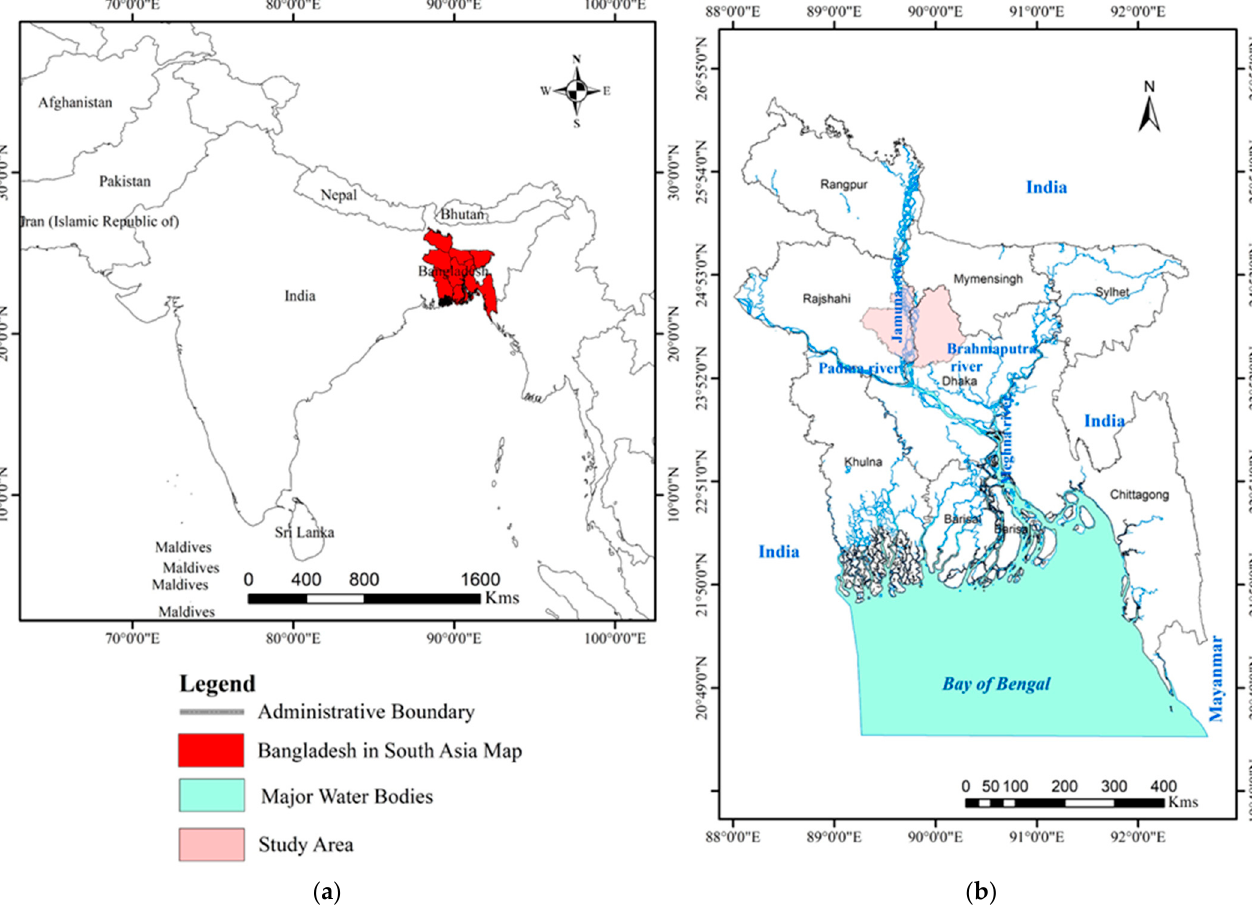
Figure 1. Geographical extent of the study area in Bangladesh. ( a ) Location of the Bengal Delta in the world map. ( b ) River distribution flows from north to south toward the Bay of Bengal.